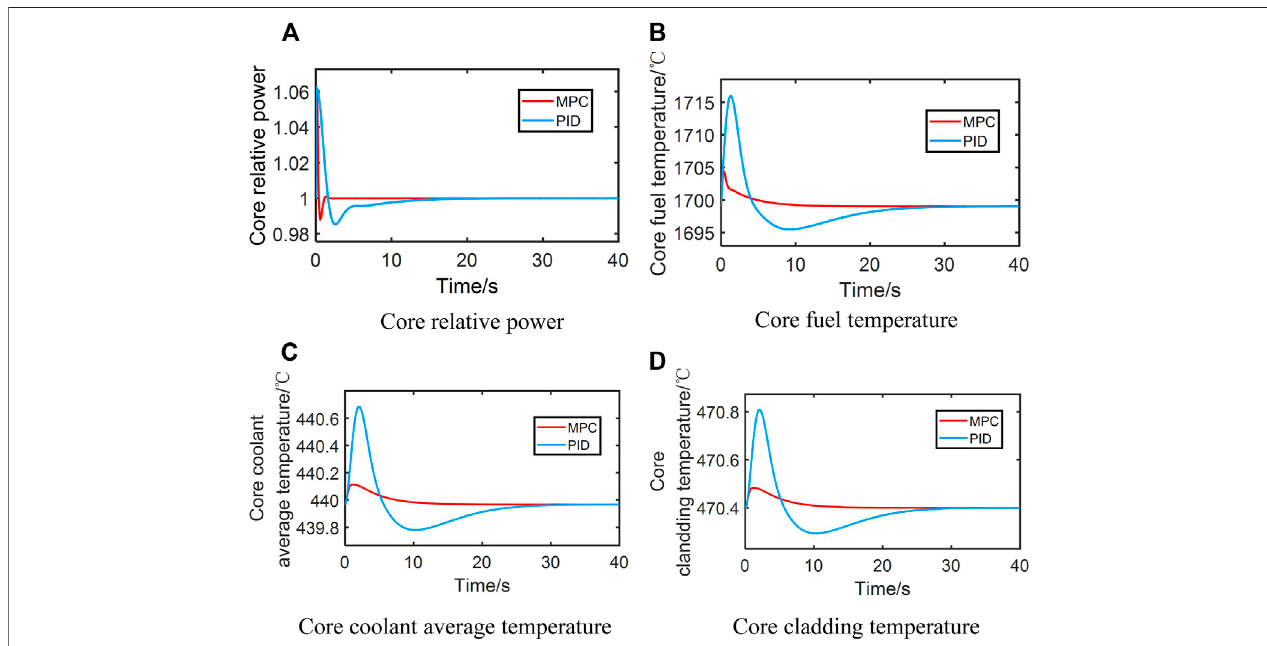
FIGURE 4 | Response of an LFR core power control system after introducing 20 pcm step reactivity.